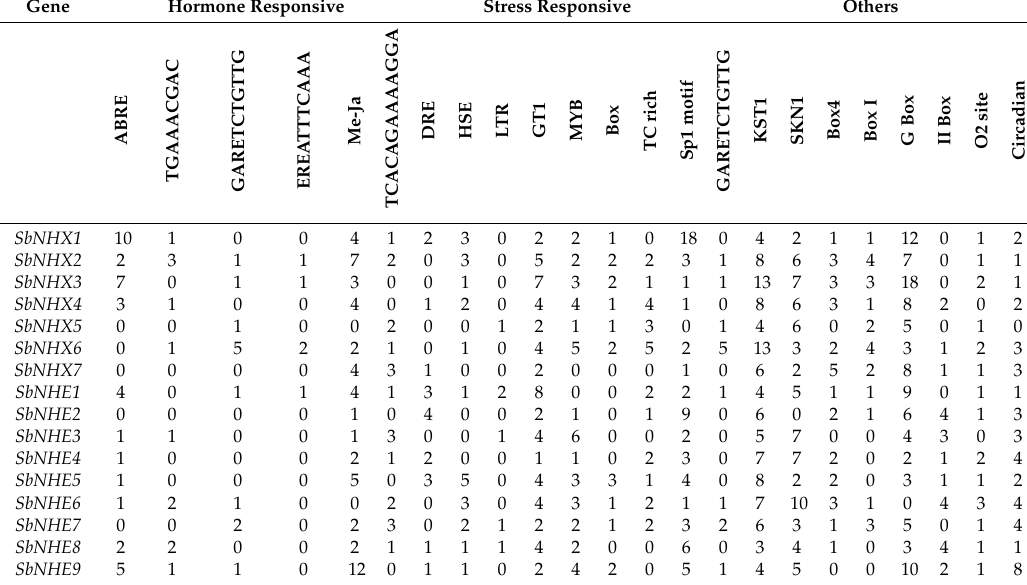
Table 3. Cis -acting element analysis of SbNHX and SbNHE gene